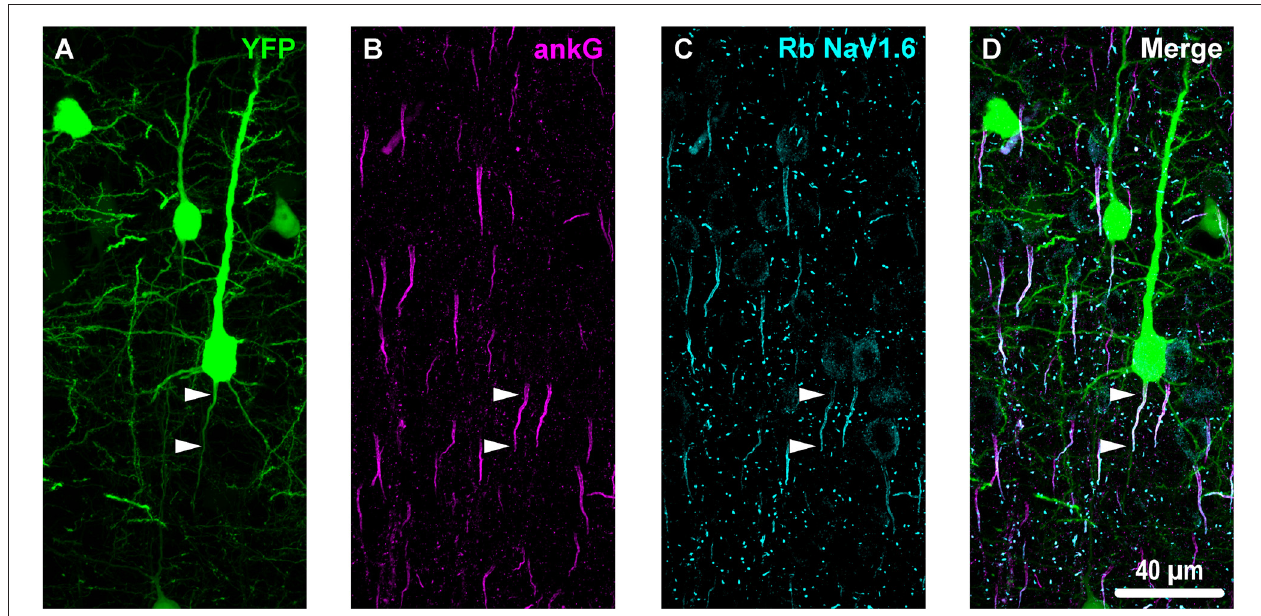
FIGURE 3 | Overview of ankyrin-G (ankG) and voltagegated sodium channels (NaV1.6) immunofluorescent profiles in YFP mice. (A) Neocortical layer 5 YFP+ pyramidal neurons (green). (B) AnkG immunoreactivity visualized using Alexa Fluor 568 (magenta) shows characteristic tapered morphology. (C) NaV1.6 immunolabeled with a polyclonal rabbit (Rb) antibody visualized using Alexa Fluor 633 (cyan) reveals shorter profiles corresponding to the distal axon initial segment (AIS). Punctate profiles indicate Nodes of Ranvier. (D) Composite image clearly demonstrating the utility of ankG as an AIS marker. The proximal axon of the YFP+ pyramidal neuron in the center of the field-of-view (FOV) colocalizes with ankG and NaV1.6, which is expressed at the distal AIS. Several ankG+ profiles highlight NaV1.6 expression at the distal AIS.